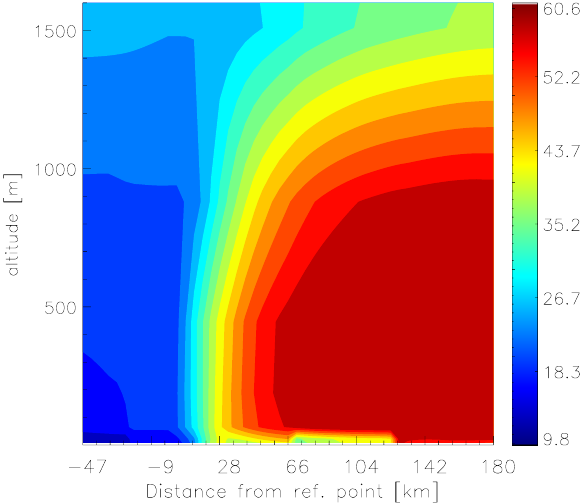
Fig. 15. Simulated O 3 mixing ratio up to 1600m altitude as a func- tion of the distance relative to the eastern city limits, with a positive value indicating the distance downwind. The simulated convective boundary layer depth reaches a maximum of about 1500